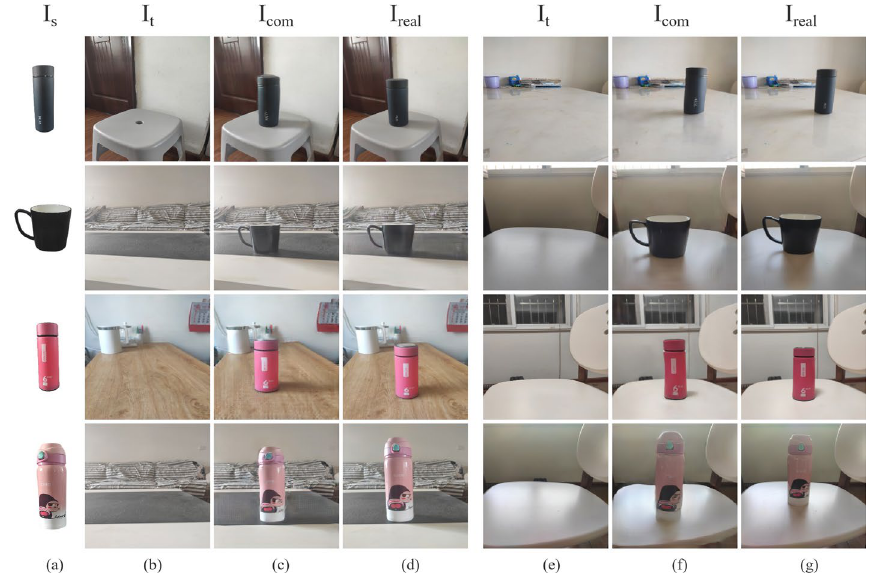
Fig. 3 Image compositing results of other source samples on SHU dataset: a source object, b target image, c compositing image, d ground truth, e target image, f compositing image, and g ground